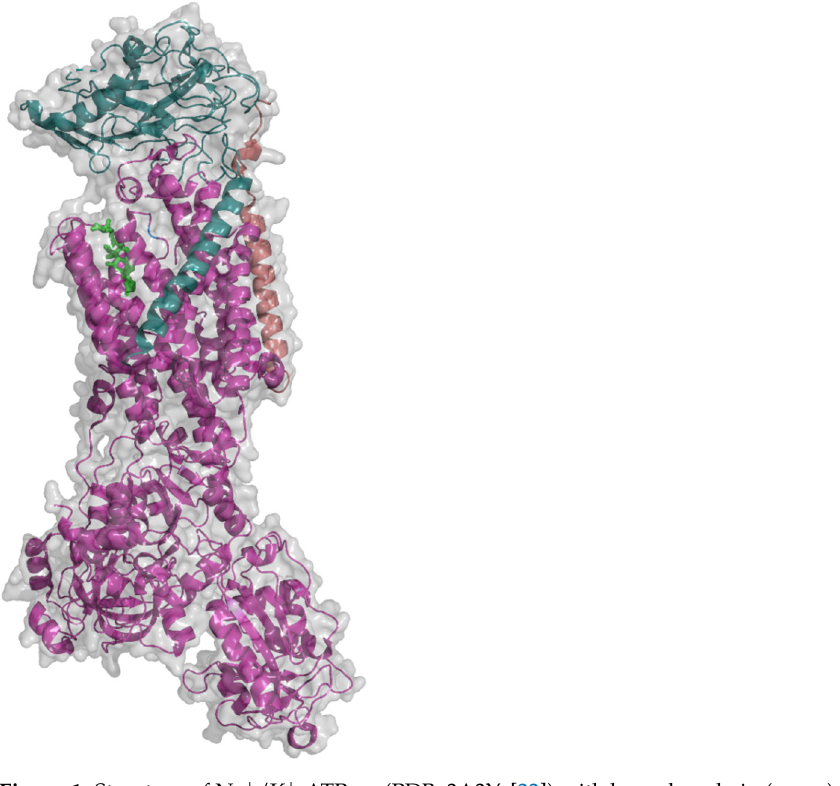
Figure 1. Structure of Na + /K + -ATPase (PDB, 3A3Y; [22]) with bound ouabain (green) in a molecular surface and cartoon view mode. Subunits are color-coded: Magenta ( α subunit), cyan ( β subunit), and orange (FXYD subunit). The image was taken using PyMOL 2.3.3.